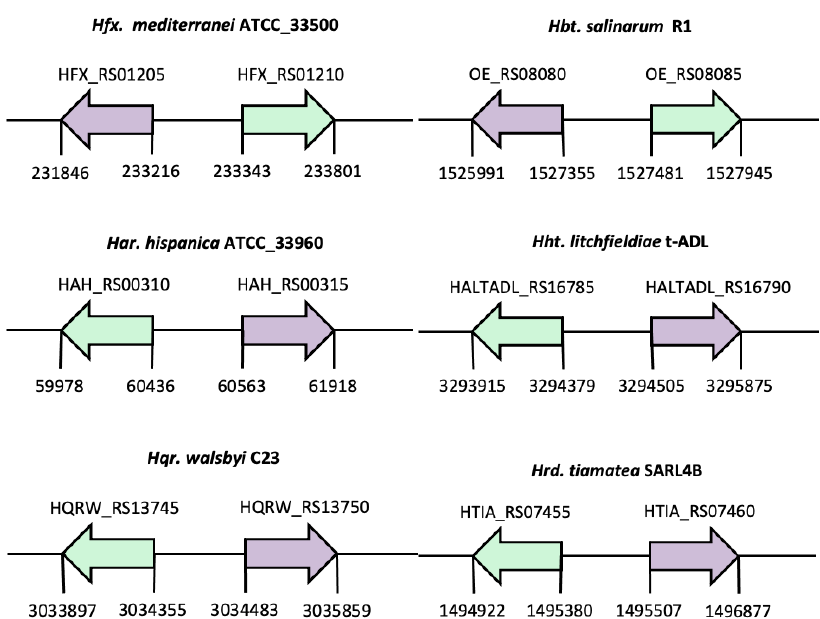
Figure 3. Gene-environment of lrp genes in halophilic organisms. In Hfx. mediterranei and Hbt. salinarum , lrp is located downstream of the glnA gene. In Har. hispanica , Hht. litchfieldiae , Hqr. walsbyi or Hrd. tiamatea, the lrp is located upstream of the glnA . Both genes are orientated in opposite directions. In green lrp gene and purple glnA .